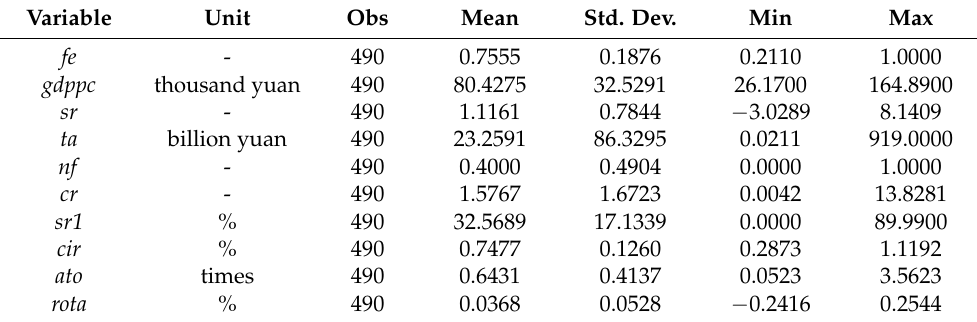
Table 4. Variable descriptive statistics.